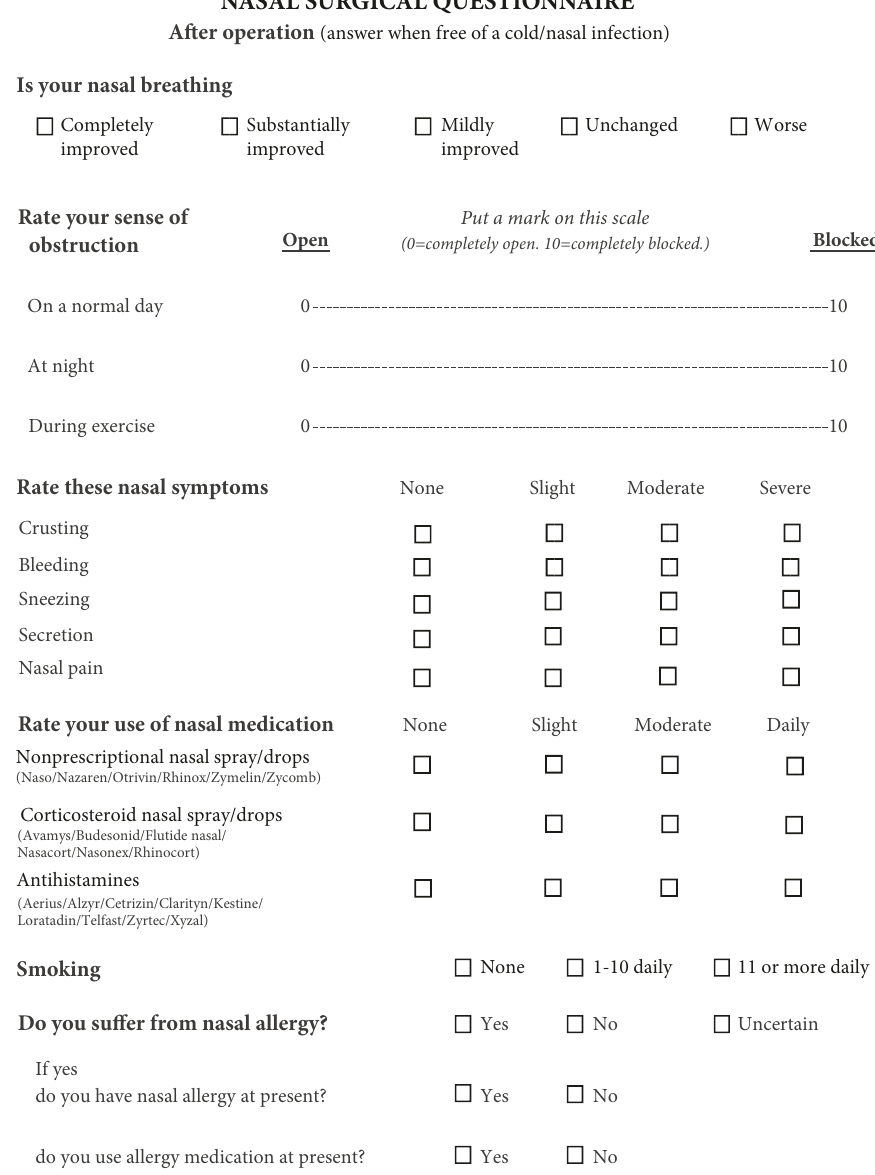
Figure 1: Nasal Surgical Questionnaire (postoperative